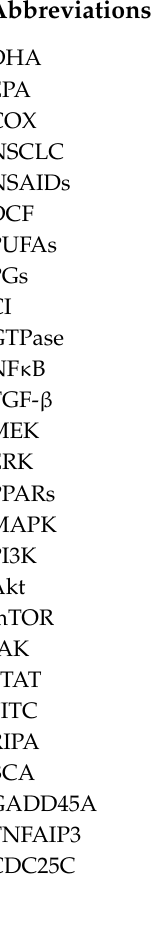
Figure S1: Detailed information about western blot in Figure 7, Figure S2: Detailed information about western blot in Figure 8, Table S1: The major pathways and genes whose levels of expression were significantly altered in A549 and H1573 cancer cell lines treated with the indicated concentrations of DHA and